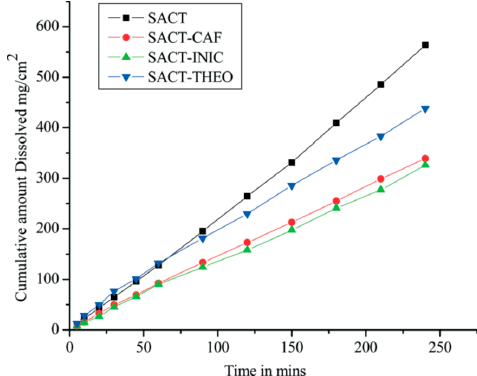
Figure 15. Intrinsic dissolution of sulfacetamide cocrystals in pH = 7 phosphate buffer. Adapted with